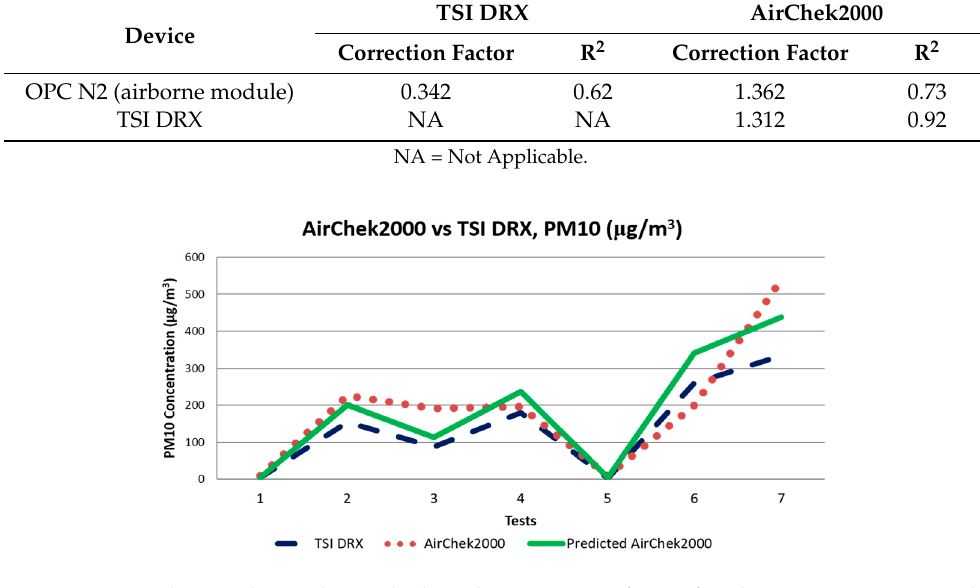
Figure 7. Correlation obtained to calculate the correction factor for the TSI DRX against the gravimetric sampler.